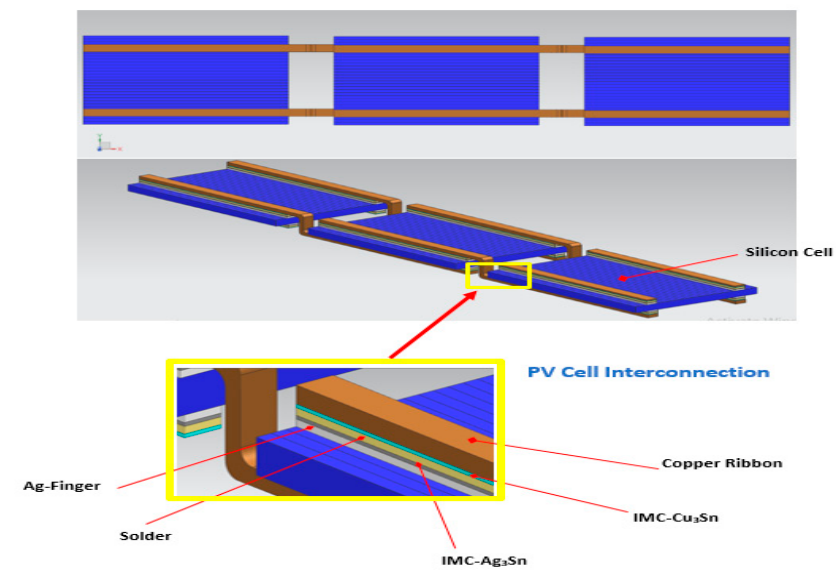
Figure 4. Conventional front-to-back cell interconnection technology in c-Si PV module. Geometric models of solar cells were interconnected in this study using two separate solder formulations as interconnecting materials, namely Pb60Sn40 and Sn3.8Ag0.7Cu.